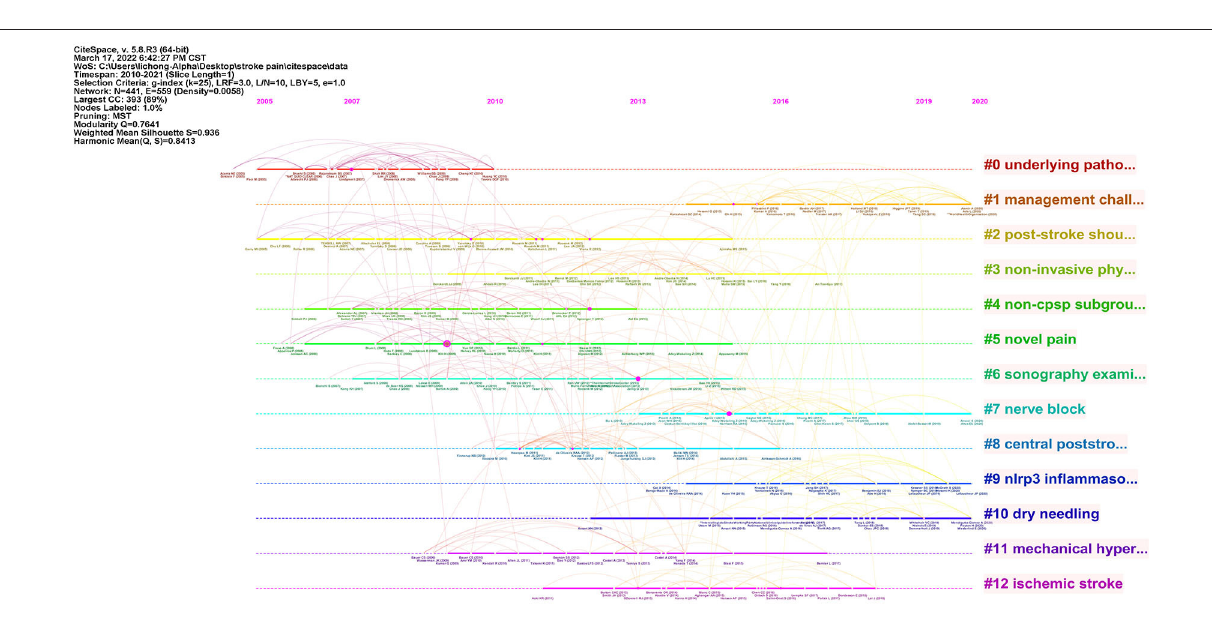
FIGURE 5 | The number of articles, open-access articles, citations, H-index, and citations per article of the top 15 subject categories of Web of Science (WoS).